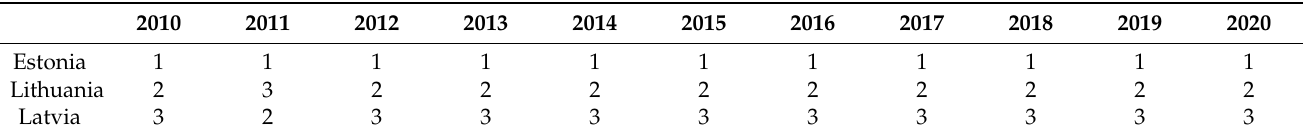
Table 4. Assessment of investment attractiveness of the Baltic states based on the TOPSIS method (with different weight factors).